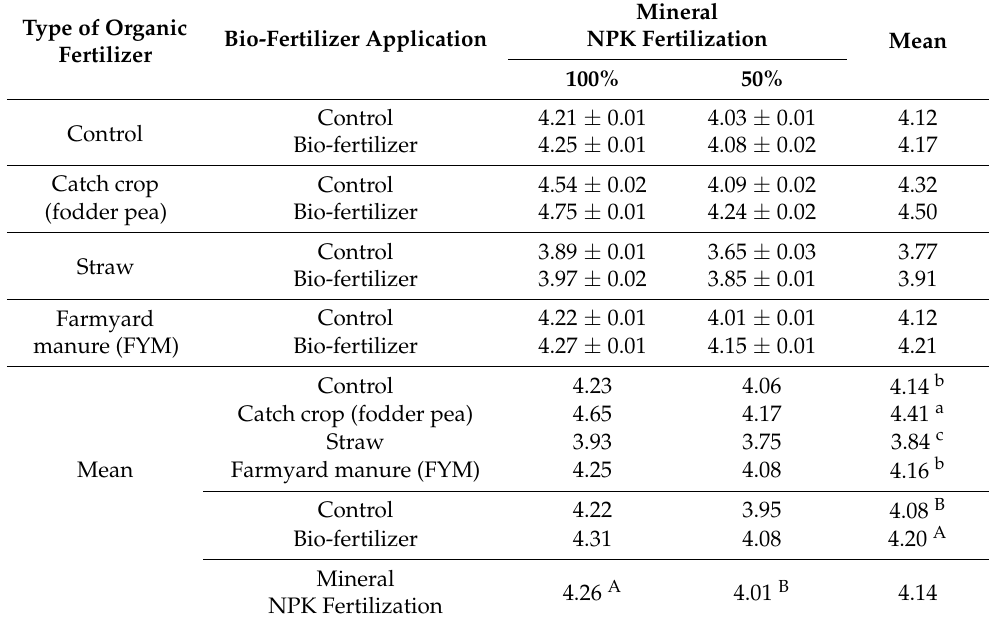
Table 6. Total polyphenols content in potato tubers after 6 months of storage depending on the applied research factors (g GAE kg –1 DM) (mean from 3 years).